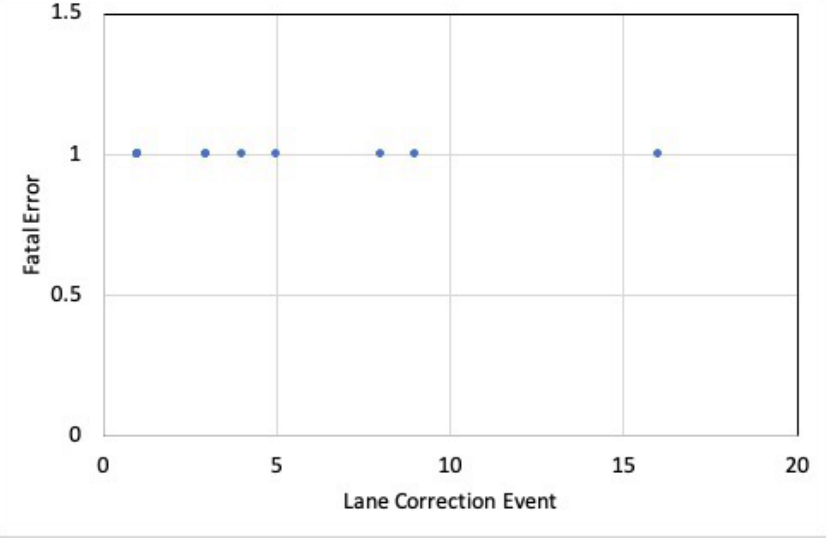
Figure 10. Fatal error vs. lane corrections events for test